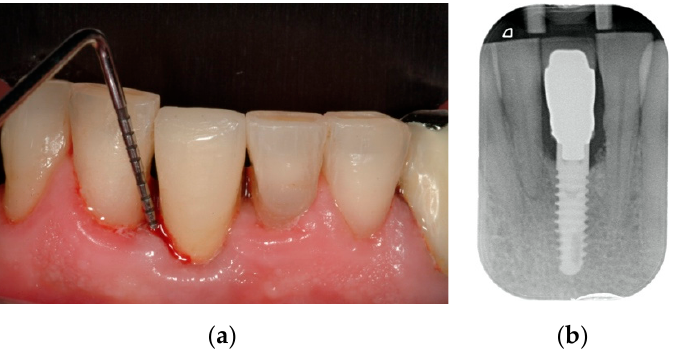
Figure 1. Peri-implant mucositis site of a lower right central incisor: ( a ) sign of bleeding on probing, and ( b ) radiographical evaluation showing no bone loss around implant collar.